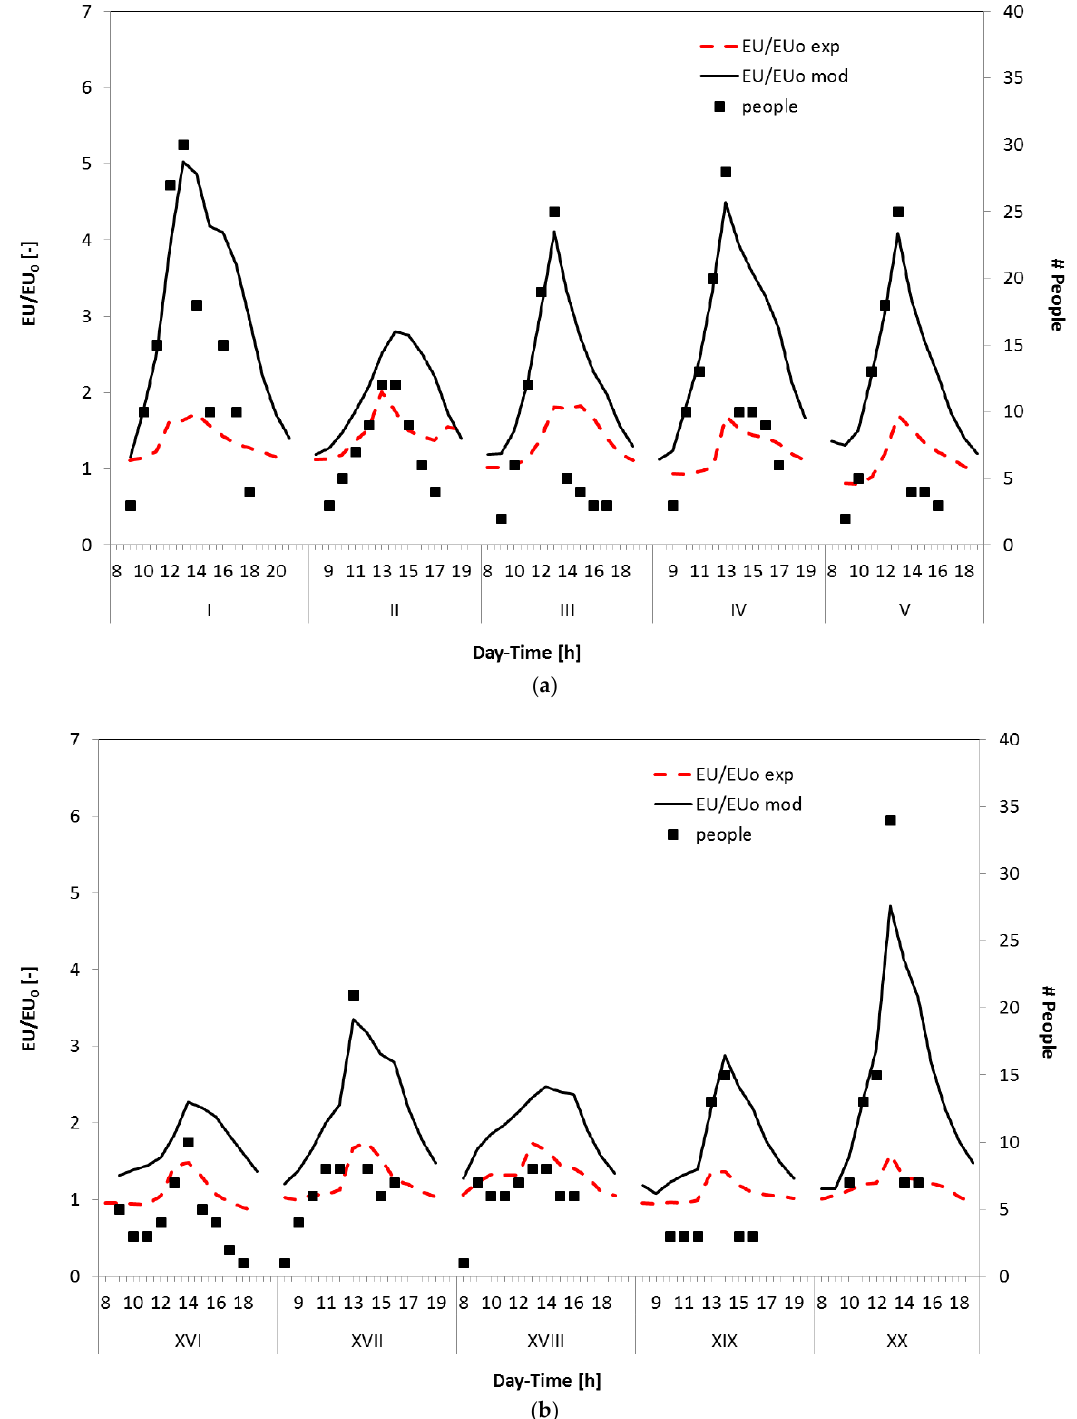
Figure 7. Experimental and predicted EU/EU 0 trends and number of occupants inside the naturally ventilated room investigated for the period from day I to V ( a ); and for the period from day XVI to XX ( b ).